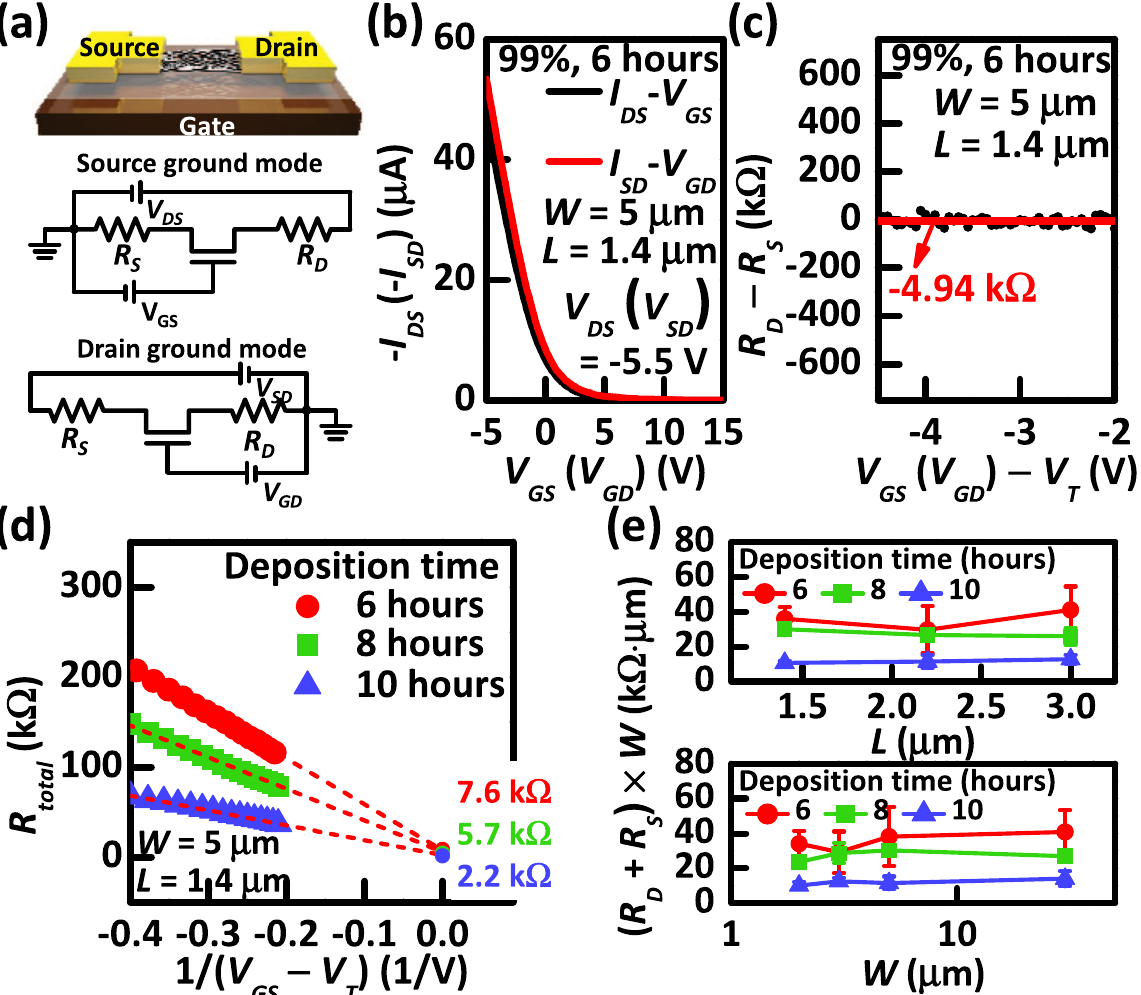
Figure 3. ( a ) Schematic illustration and equivalent circuits with R S and R D of the source and drain ground mode for CNT-TFTs. ( b ) Measured transfer characteristics for the source and drain ground mode. ( c ) The difference of R D and R S , i.e., R D − R S , calculated from two transconductances ( g mS and g mD ) obtained from the measured transfer characteristics in the source and drain ground mode. ( d ) R total vs. 1/( V GS − V T ) for the channel resistance method (CRM). The combined contact resistance, i.e., sum of R D and R S , is extracted as 7.6, 5.7, and 2.2 kΩ at 1/( V GS − V T ) = 0 with different densities of CNTs in the network. ( e ) Normalized R D + R S vs. L and W for CNT-TFTs with different densities of CNTs in the